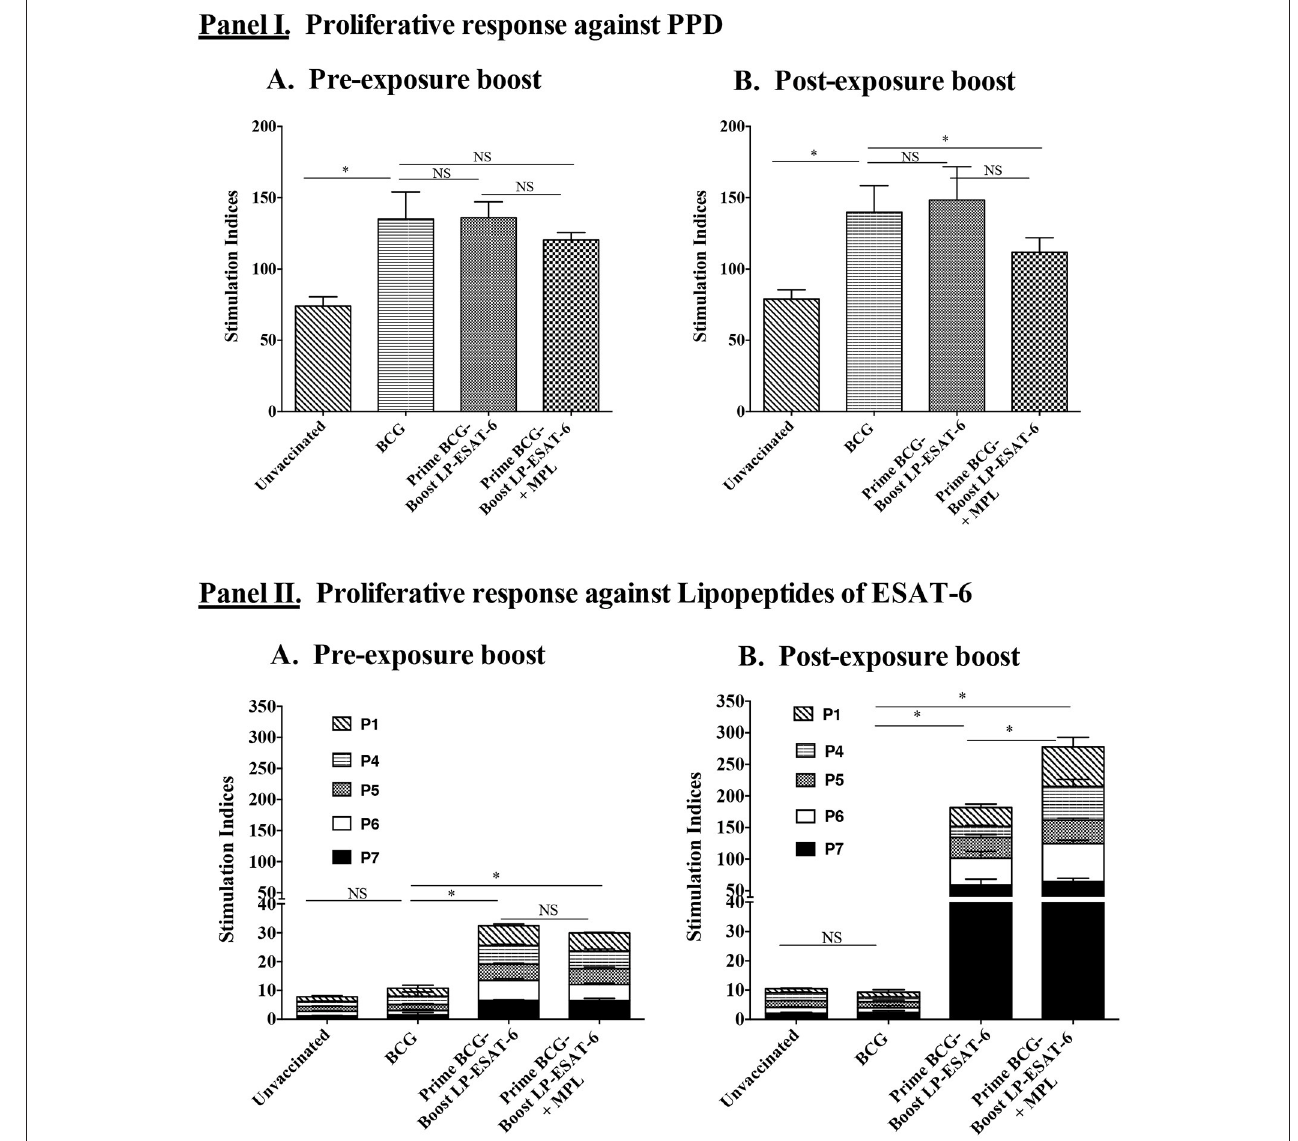
FIGURE 4 | Proliferative responses of splenocytes upon ex vivo stimulation with PPD or individual lipopeptide components of LP-ESAT-6 subunit vaccine. Female BALB/c mice ( n = 5/group) were immunized according to the pre-exposure or post-exposure schedule shown in Figure 1 . Four weeks after infection, mice were euthanized and spleens were collected from (A) pre-exposure boost and (B) post-exposure boost groups to examine the antigen-specific proliferation of T cells. Briefly, T cells obtained from splenocytes (pooled from 5 mice of a group) were cultured with irradiated APCs (splenocytes from unimmunized mice) and with medium, PPD (1 µ g/ml) (Panel I) or respective lipopeptides P1 and P4-P7 at 10 µ g/ml concentration (Panel II) for 4 days. T cell proliferation was measured by [ 3 H] thymidine incorporation. Stimulation indices were calculated as CPM of the antigen-containing cultures/CPM of medium control group. Mean ± standard deviation of stimulation indices from triplicate wells are shown. *denotes significant difference ( P < 0.05) between the compared groups and “NS” represents not significant ( P >